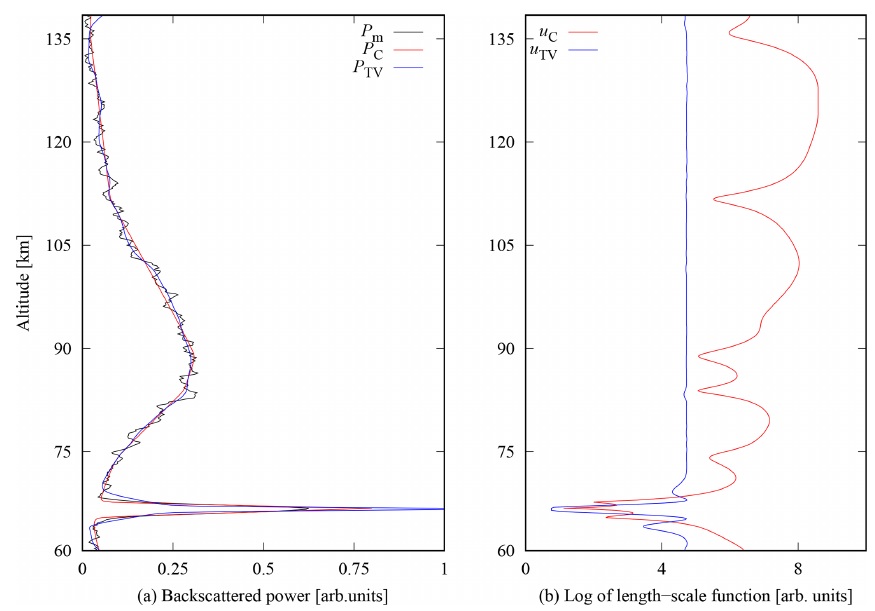
Figure 6. PMWE EISCAT data from 24 November 2006, at exactly 09:20:48UT. Comparison of the reconstructions of the unknown signal P with the Cauchy difference prior (red line, α C = 2 . 5) and TV (blue line, α TV = 1 . 0) prior (a) . The backscattered power profile after matched filtering P m are plotted with black line. Panel (b) shows corresponding values of the length-scale functions in logarithmic scale.